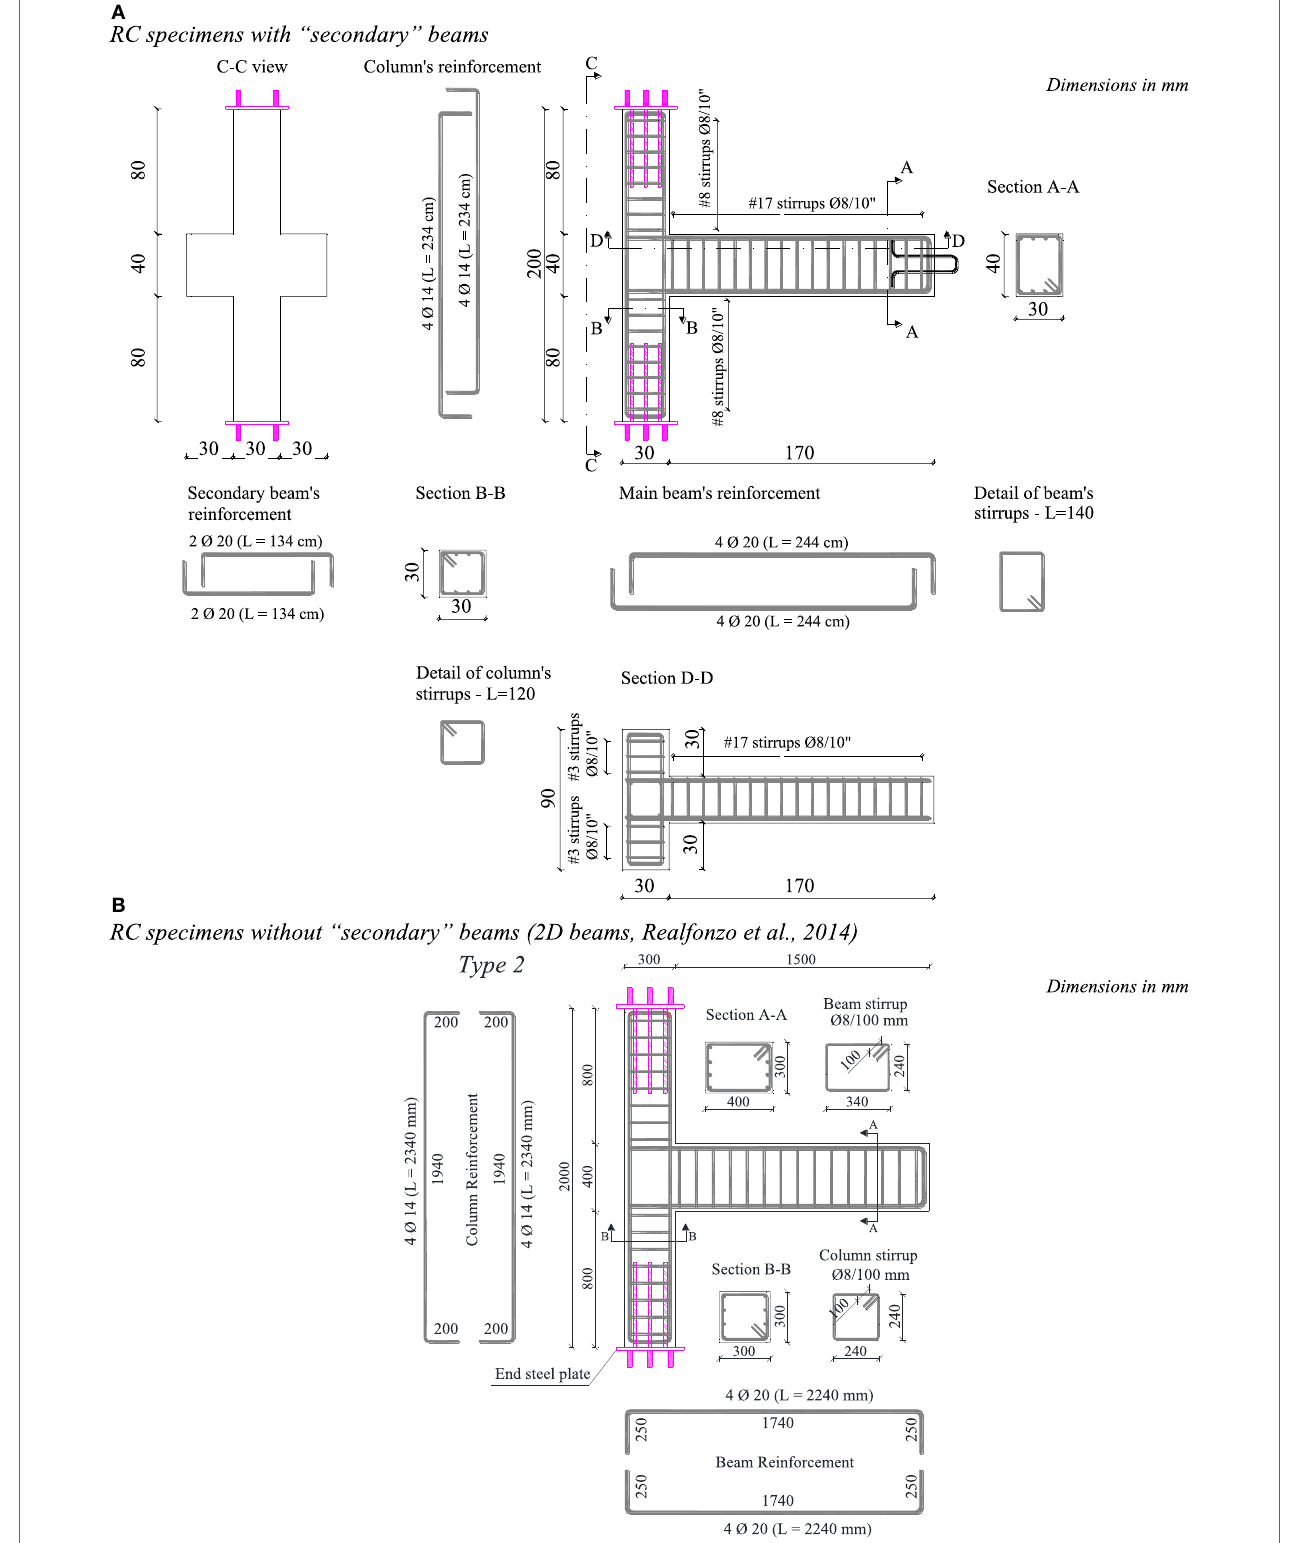
FIGURE 1 | Geometry and steel reinforcement configuration for reinforced concrete specimens with (A) and without (B) “secondary” beams.